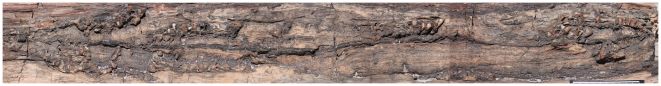
Composite field photograph of PEFO log specimen containing borings diagnosed here as Xylokrypta.Borings concentrated along longitudinal furrow. Scale bar at lower right is 10 cm, with 1 cm increments.